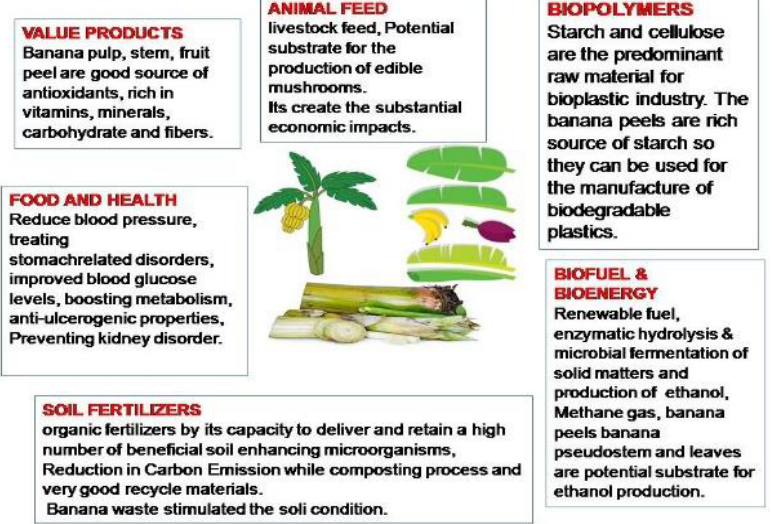
Figure 6. Various applications and uses of biomass from banana plantations.